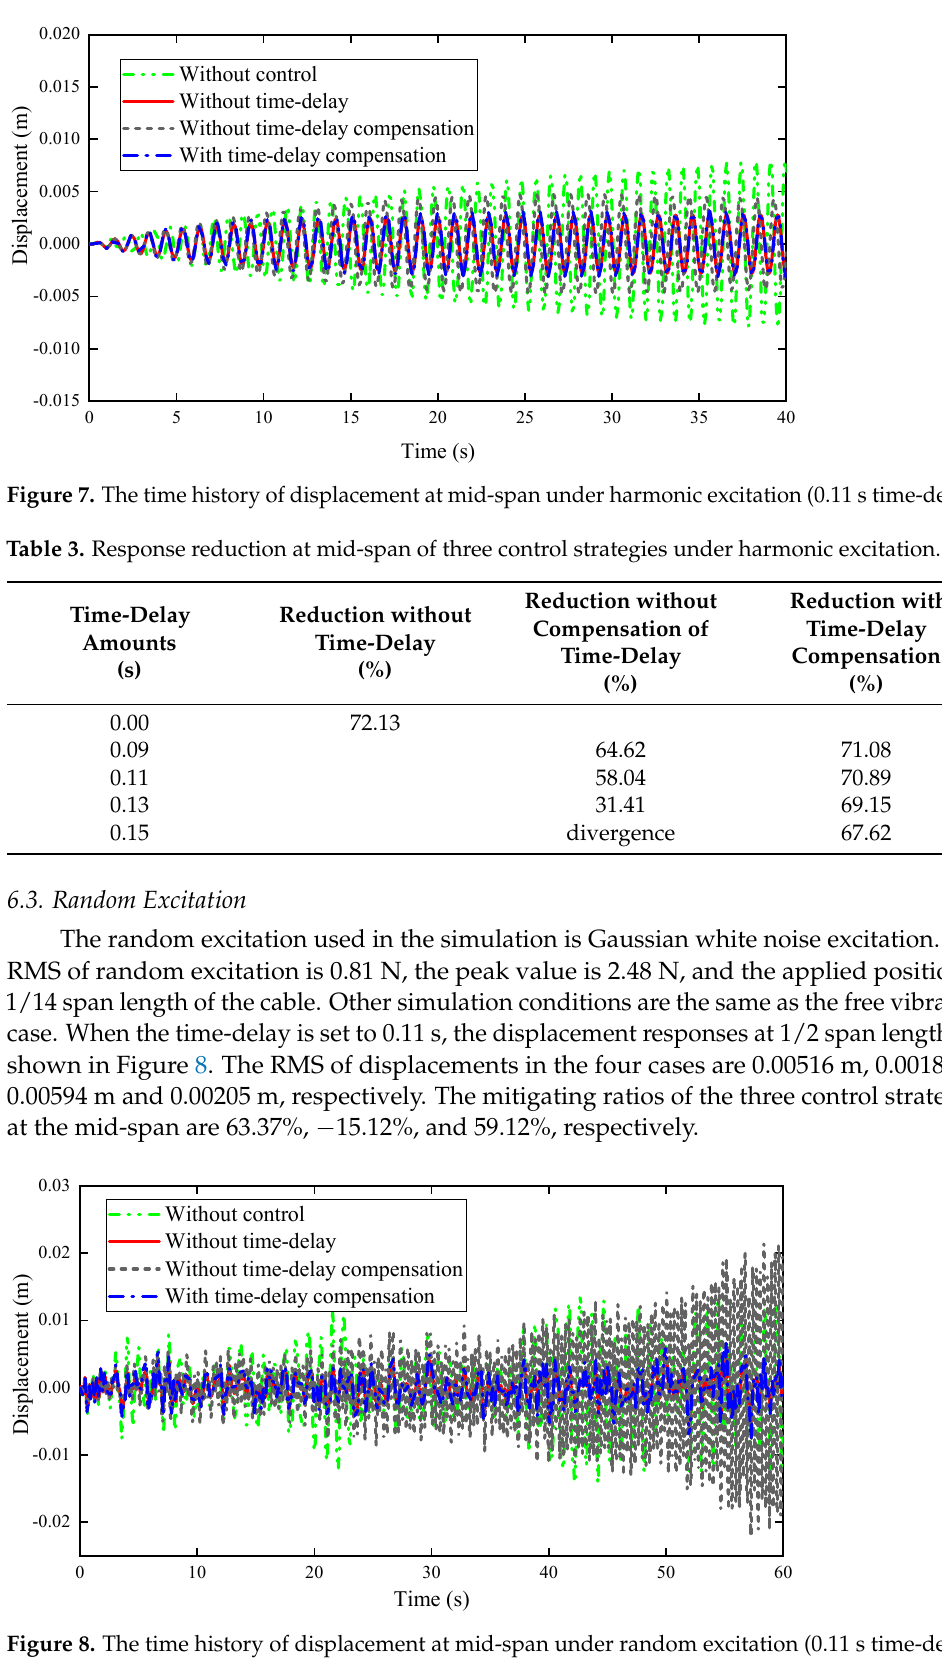
Table 4. Response reduction at mid-span of three control strategies under random excitation. The Time-Delay (s)